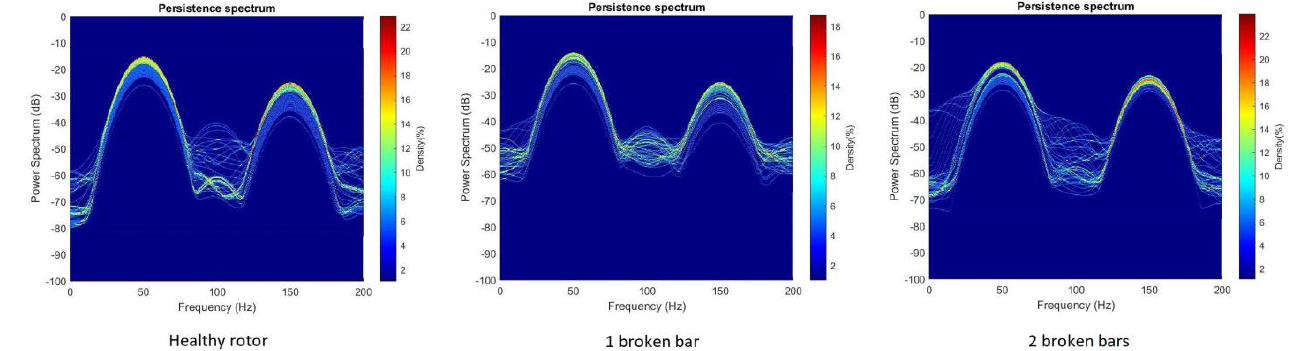
Figure 6. PS images for the ABB model, with nominal load and with the time-ramp set in 20 s and initial voltage set in 40%, for the three health cases: Healthy, one broken bar and two broken bars. All obtained from the captured stray-flux signal.